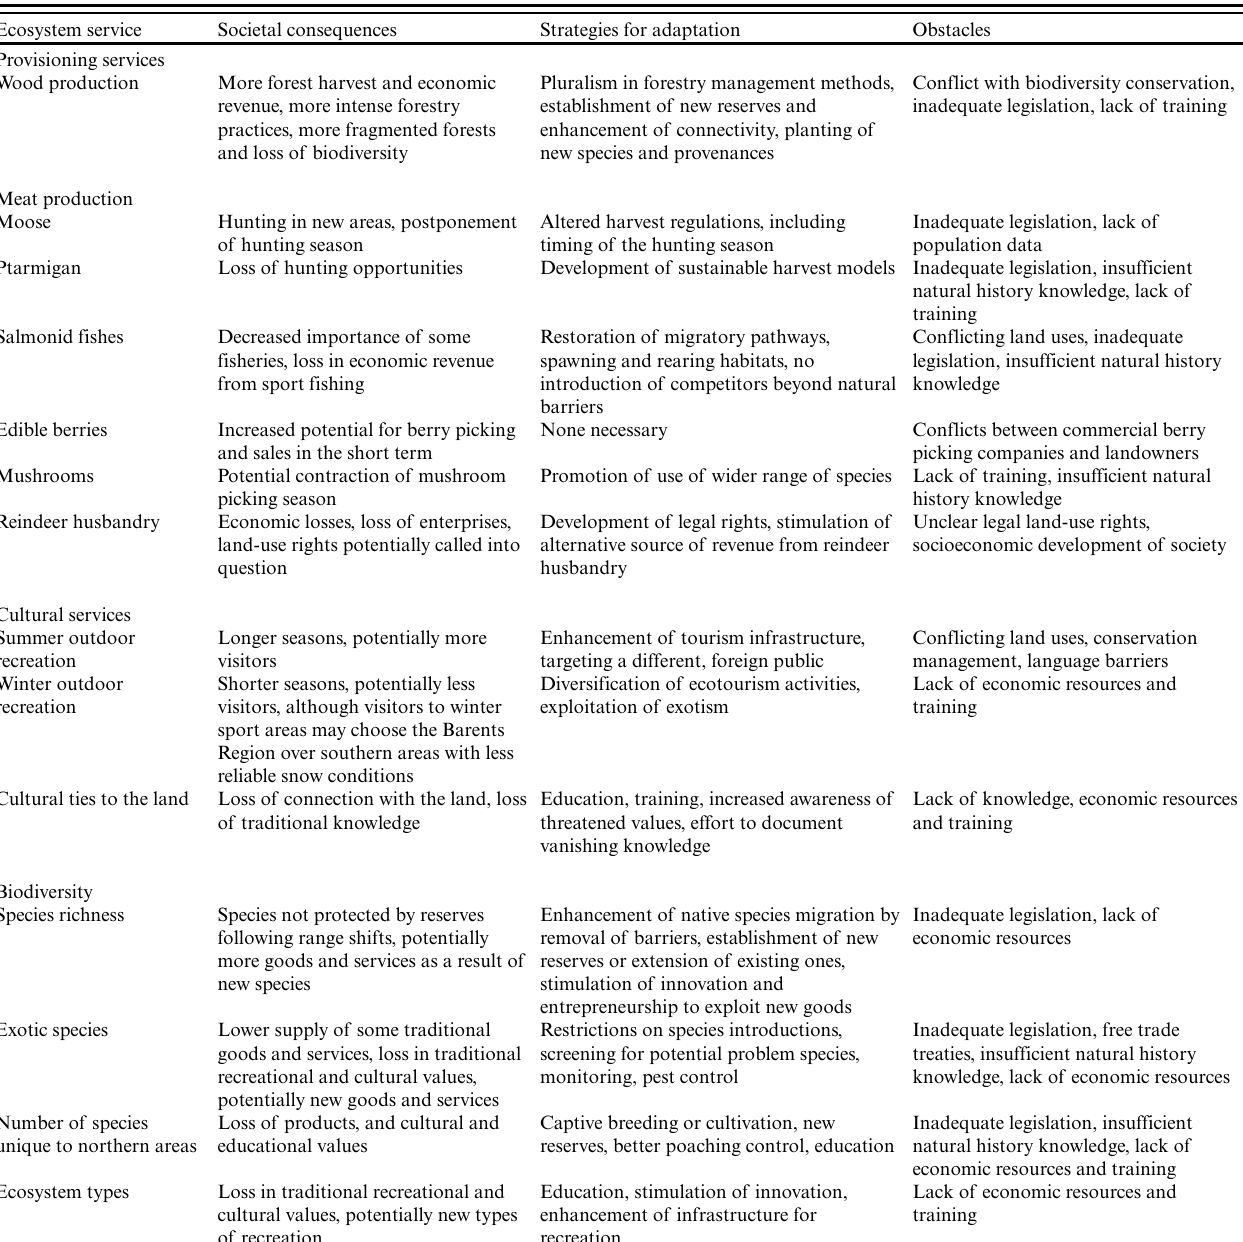
Table 2 . Societal consequences of changes in ecosystem service provision caused by climate change in the Barents Region, recommended strategies to adapt to changes, and obstacles to